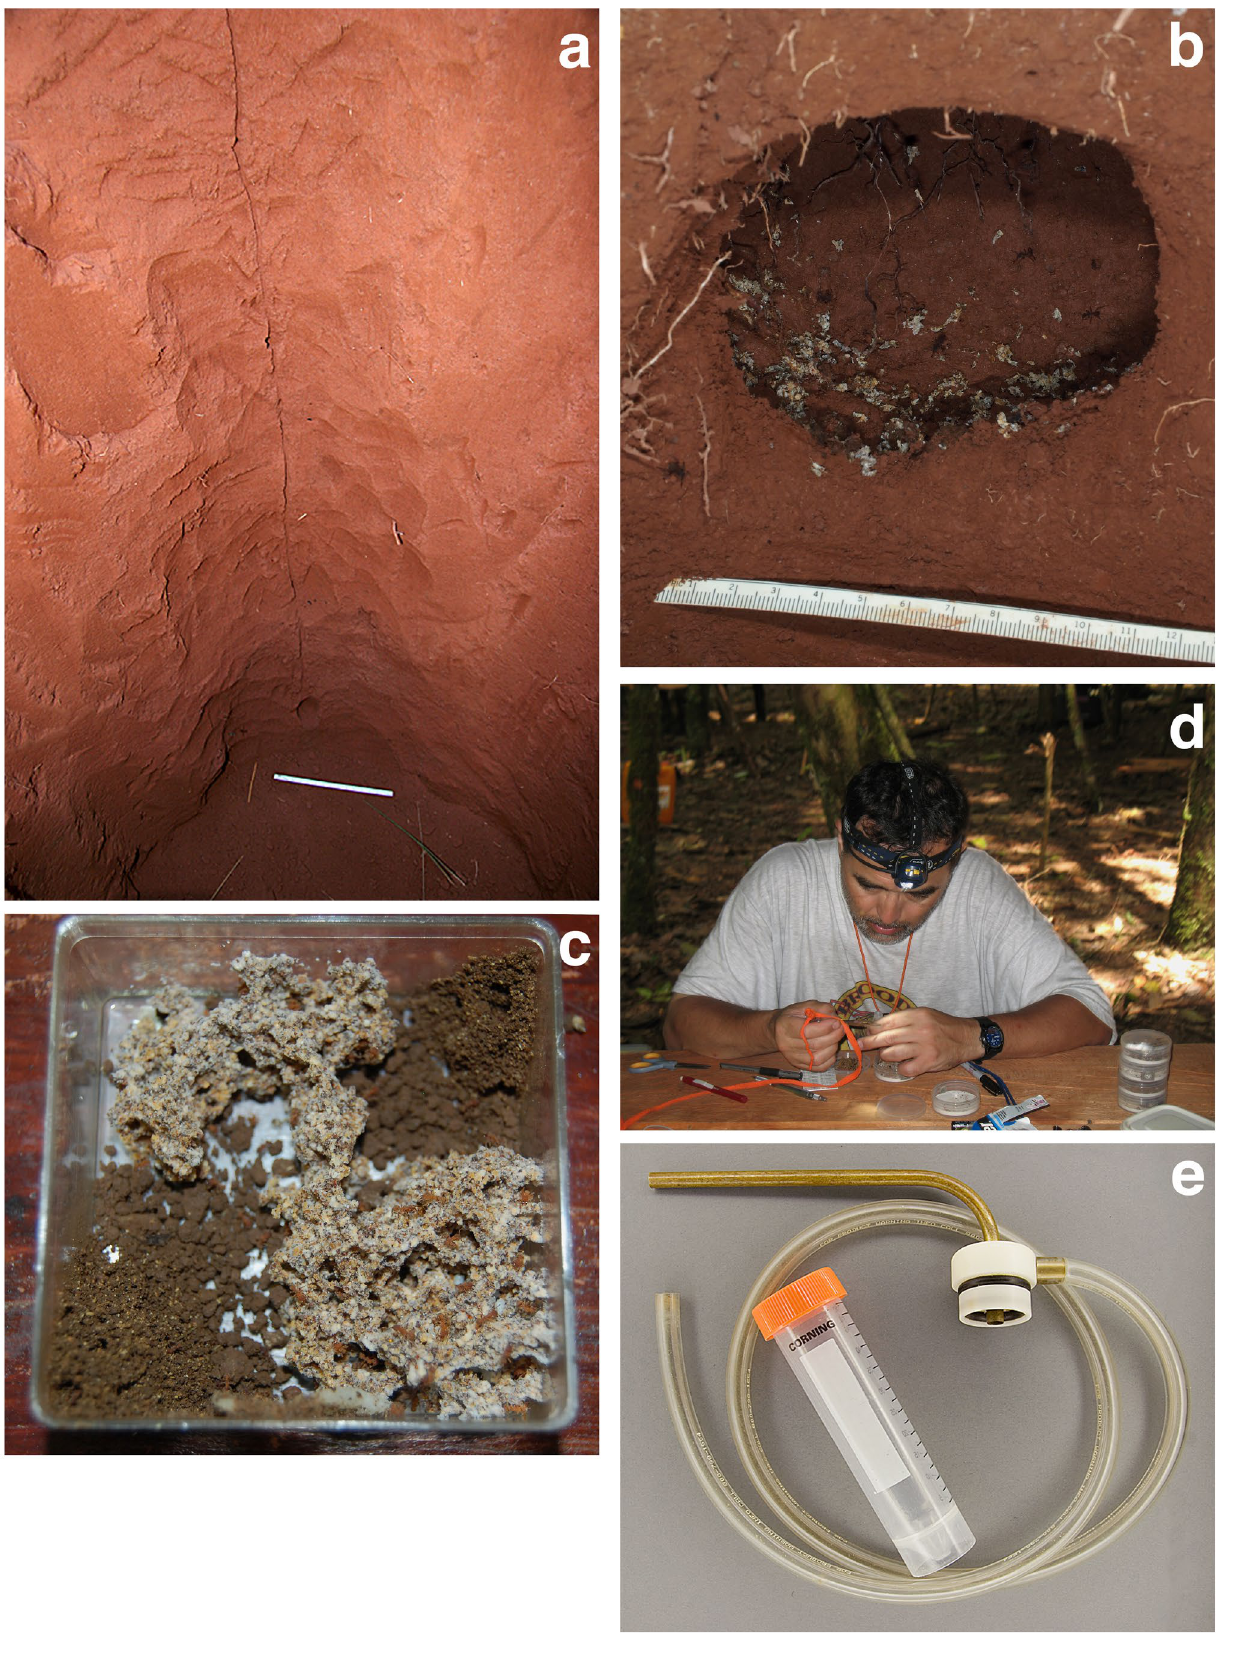
Fig 2. Field collection and care of fungus-farming ants. a. Vertical tunnel and empty chamber of Mycetagroicus cerradensis. b. Empty garden chamber of Apterostigma sp. with garden remnants on chamber floor. c. Restabilized fungus garden of Sericomyrmex sp. after ants have separated garden and soil particles. d. Daily care of fungus-farming ants in the field. e. Rose Entomology “Bug Vac” receptacle aspirator and 50 ml clear plastic centrifuge tube with